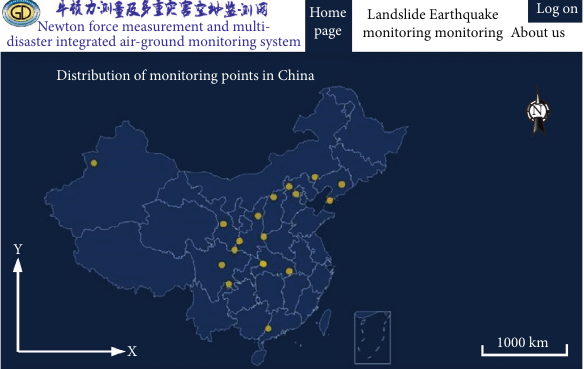
Figure 13: The publishing software interface of the monitoring system deployed on a cloud server (schematic diagram of moni- toring points deployed in China).